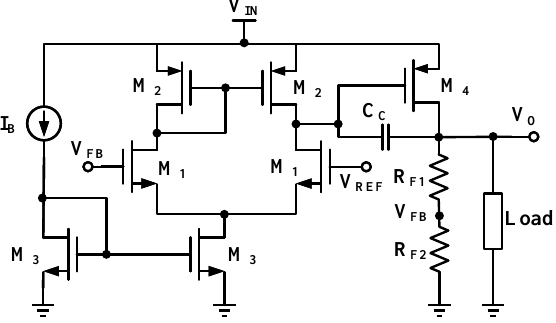
Figure 8. Circuit schematic of the capacitor-less low dropout (LDO) with type-A single stage error amplifier internal frequency compensation provided by C C